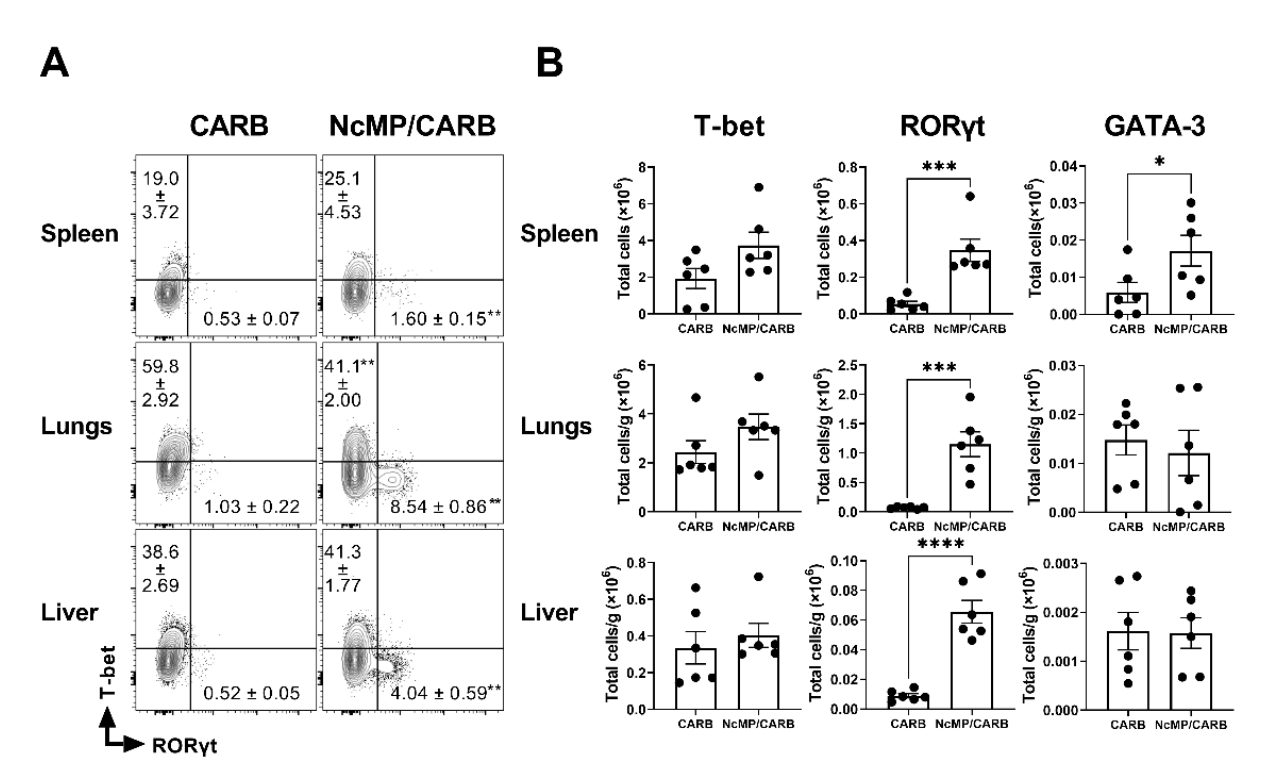
Figure 7. Expression of T-bet, ROR γ t and GATA-3 in CD4 + CD44 + T cells collected from infected mice. ( A ) Representative contour plots of T-bet and ROR γ t expression in CD4 + CD44 + T cells in the indicated organs of sham-immunized (CARB) or immunized (NcMP/CARB) mice, as indicated, 7 days after i.p. challenged with 1 × 10 7 N. caninum tachyzoites. Numbers within contour plots correspond to mean percentage values ± SEM of cells in the respective analysis regions. ( B ) Numbers of CD4 + CD44 + T cells expressing T-bet, ROR γ t and GATA-3 in the indicated organs of infected mice of NcMP/CARB and CARB mouse groups. Each symbol (black circle) represents an individual mouse. Results are representative of two independent experiments that yielded concordant results ( n = 6 group; * p < 0.05; ** p < 0.01; *** p < 0.001; **** p < 0.0001, Mann – Whitney).